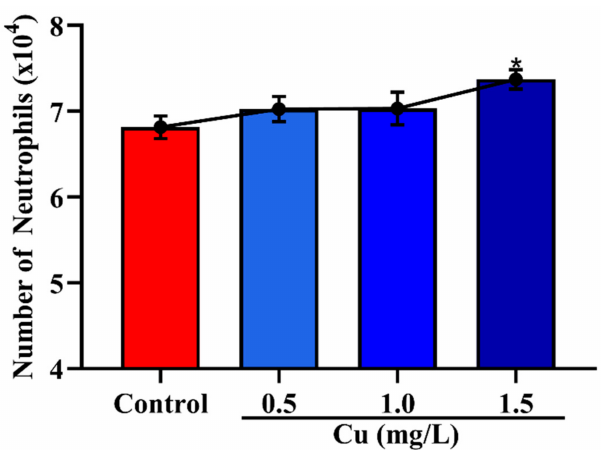
Figure 3. Effects of Cu on the migration of neutrophils in the trans-mammary epithelium. * p < 0.05 between the different concentrations of Cu (0.5, 1.0 and 1.5 mg/L) group and the control group in the same batch. Each value represents the mean ± SEM, n =